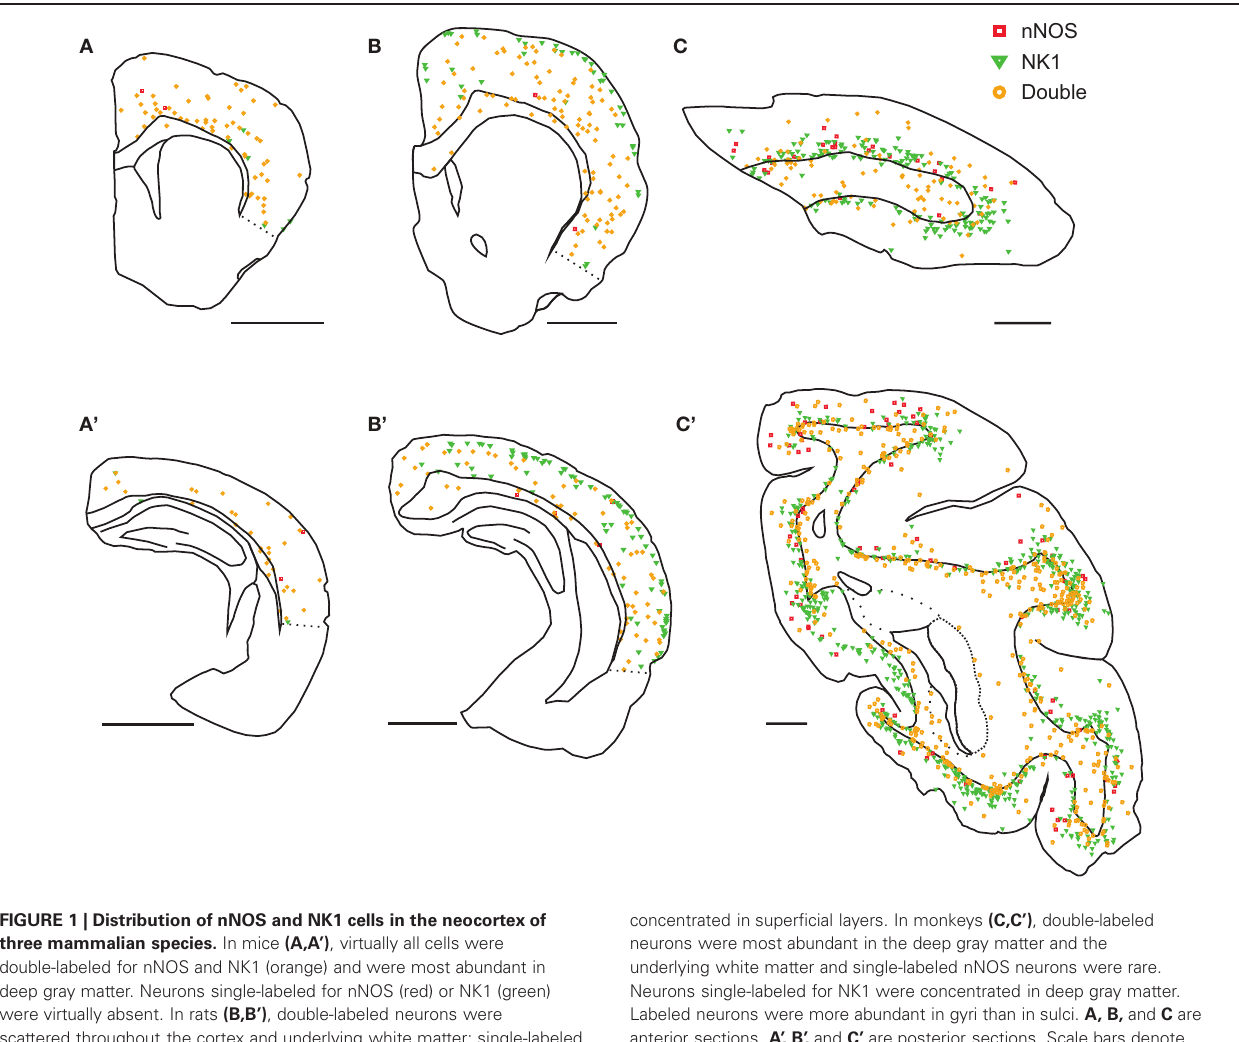
FIGURE 1 | Distribution of nNOS and NK1 cells in the neocortex of three mammalian species. In mice (A,A’) , virtually all cells were double-labeled for nNOS and NK1 (orange) and were most abundant in deep gray matter. Neurons single-labeled for nNOS (red) or NK1 (green) were virtually absent. In rats (B,B’) , double-labeled neurons were scattered throughout the cortex and underlying white matter; single-labeled nNOS neurons were virtually absent. Neurons single-labeled for NK1 were